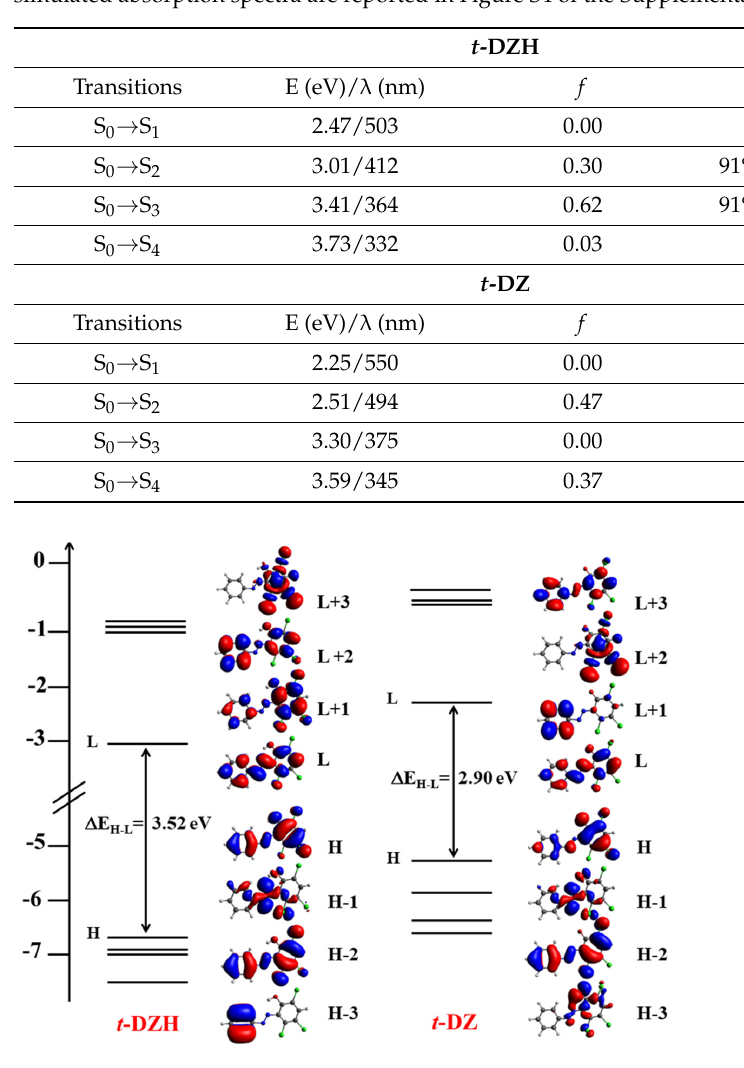
Figure 3. Schematic representation of the energy levels of the frontier molecular orbitals for t -DZH and t -DZ along with the isodensity surface plots of HOMO—HOMO − 3 and LUMO—LUMO+3 having isodensity contour equal to 0.03 (H and L stand for HOMO and